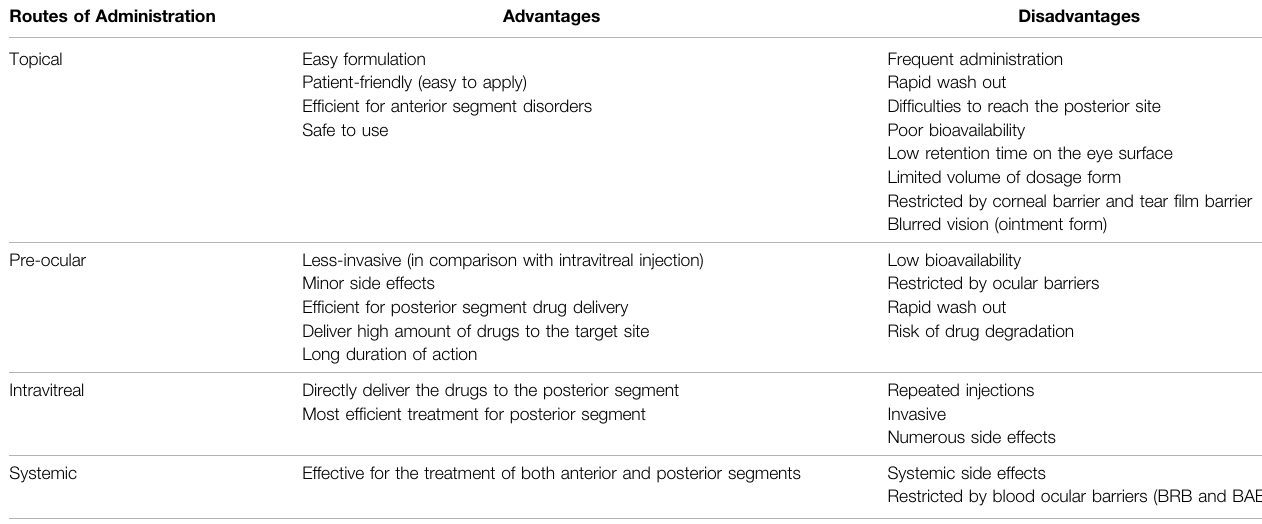
TABLE 1 | Routes of administration and their bene fi ts and pro fi ts.